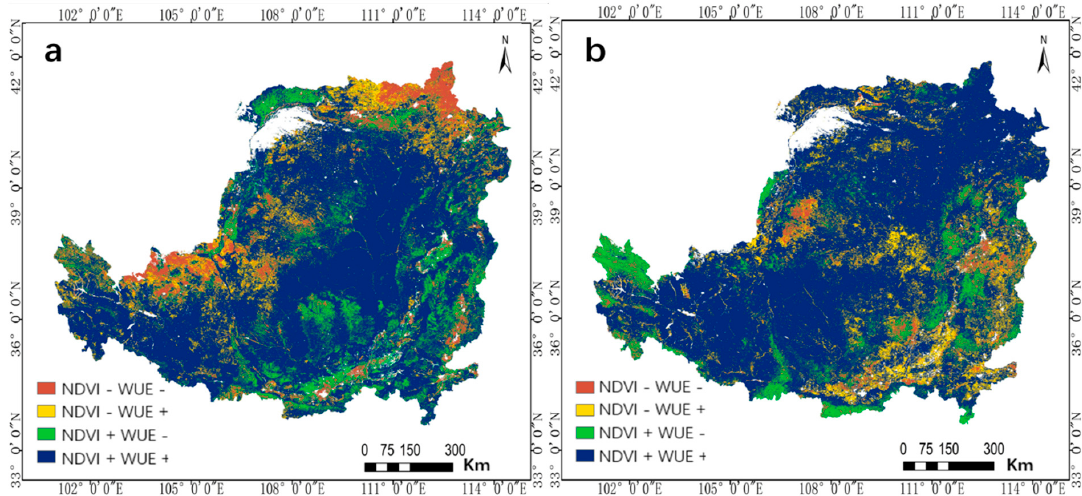
Figure 5. ( a ) Distribution map of NDVI and WUE area change from 2001 to 2010. ( b ) Spatial distribution map of NDVI and WUE from 2011 to 2020.